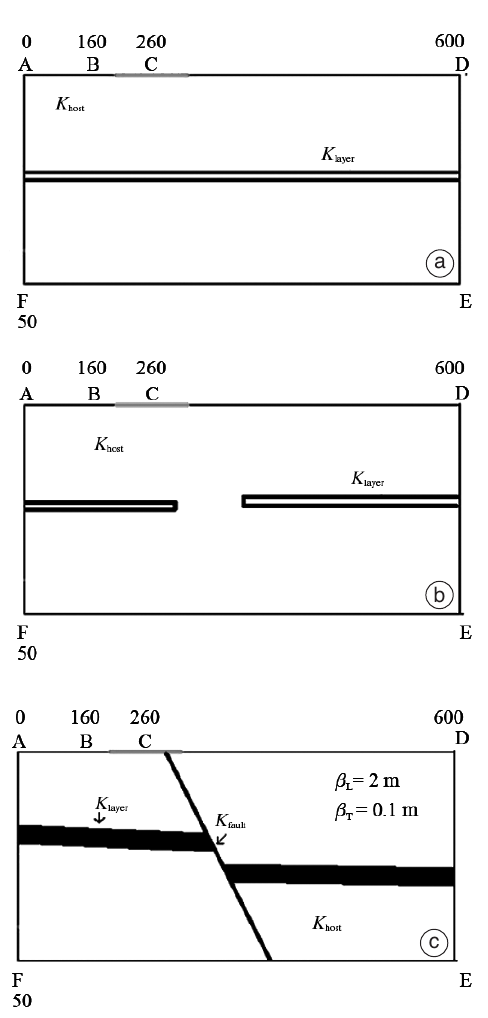
Fig. 1a-c. a) Model 1, one intervening layer of low- er hydraulic conductivity; b) Model 2, discontinuous layer; c) Model 3, layer displaced by